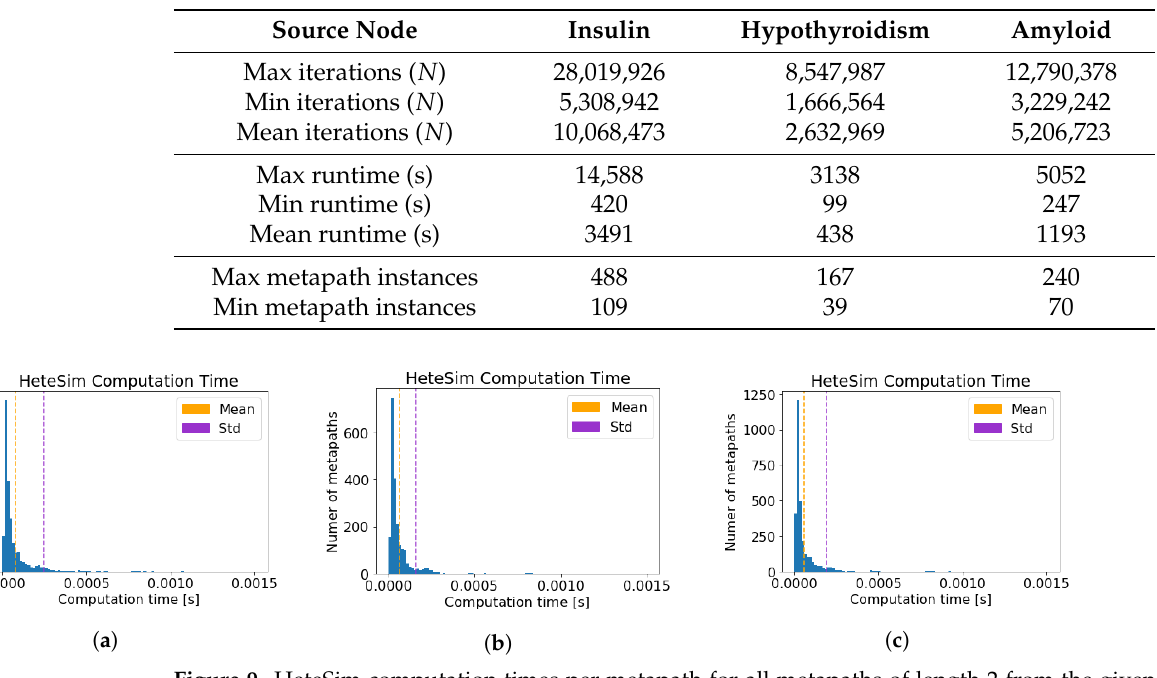
Table 5. Computation details for the randomized pruned HeteSim algorithm on the top 20 individual length 2 metapaths.